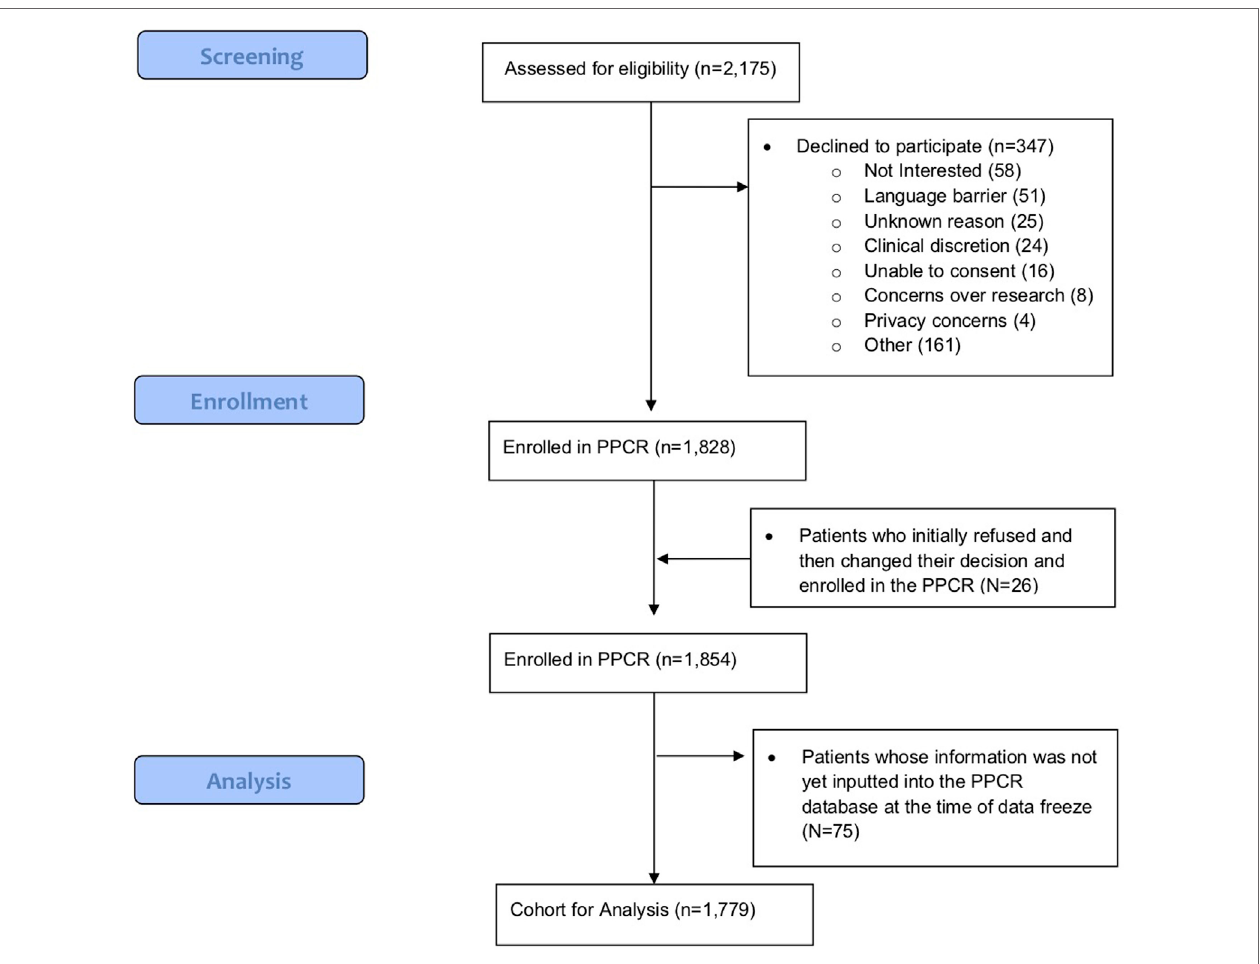
FigUre 1 | Pediatric Proton Consortium Registry (PPCR) enrollment flow diagram.